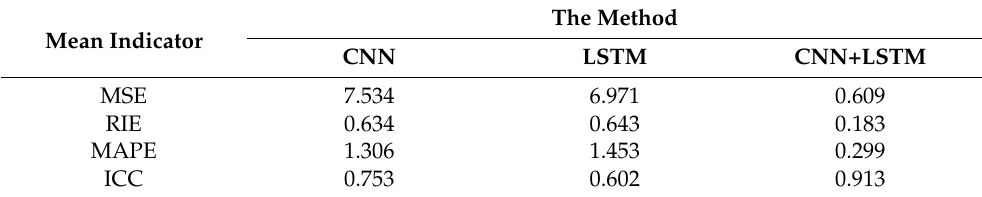
Table 7. Indicators characterizing the mean quality of testing reconstructions.